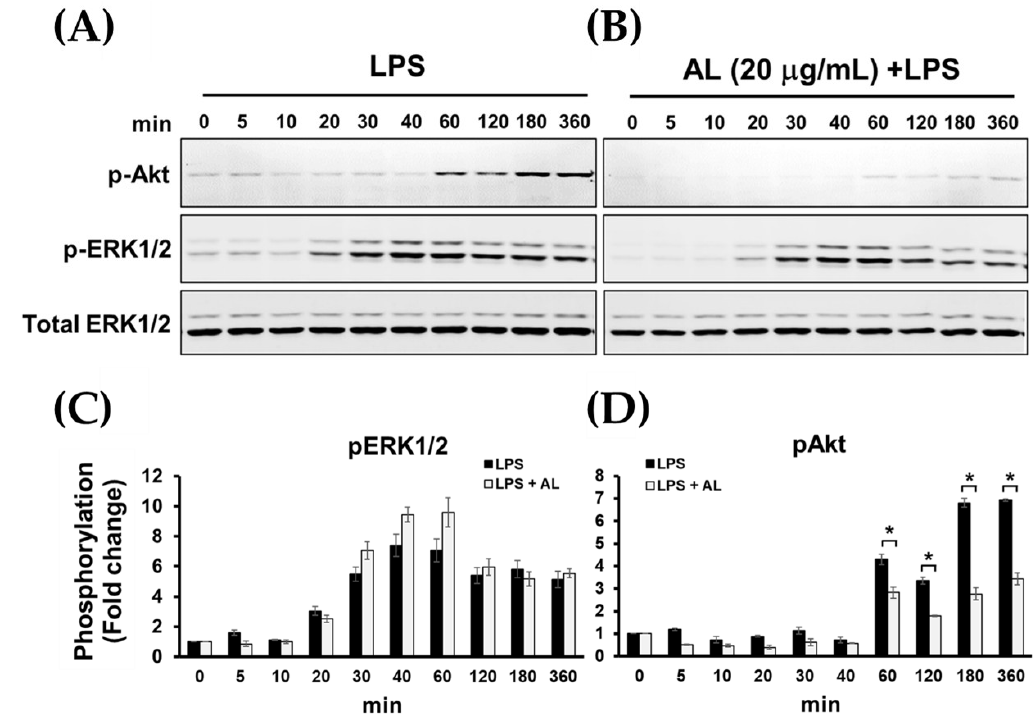
Figure 9. ( A ) Western blot analysis for the phosphorylation of Akt and ERK1 / 2 of RAW 264.7 cells induced with LPS for various time points (0–360 min); ( B ) the inhibitory e ff ects of AL extract on the phosphorylation of Akt and ERK1 / 2 after LPS stimulation for various time points, total ERK1 / 2 was detected and used as an internal control; ( C ) quantitative analysis for ERK1 / 2 phosphorylation; ( D ) quantitative analysis for Akt phosphorylation at Ser473. Data are representatives of three replicates and shown as mean ± SD; * p < 0.05.